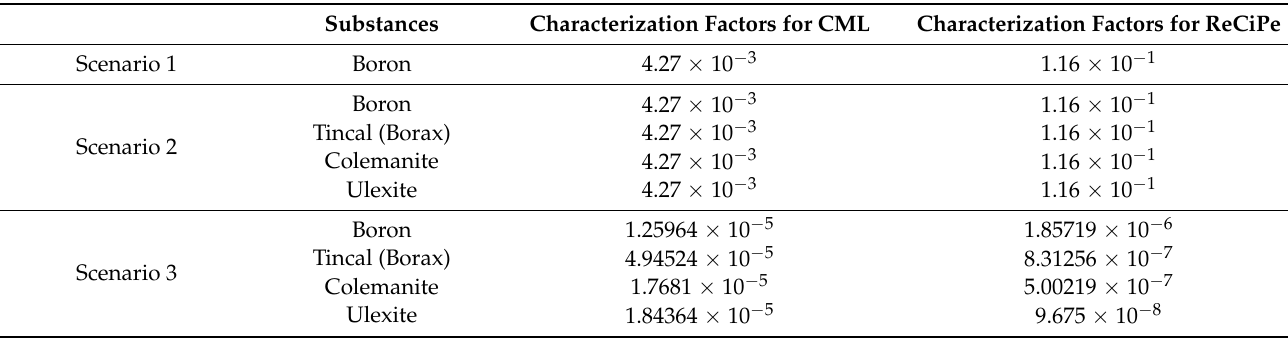
Figure 6. Results with ReCiPe expressed in kg Cu equivalents. Table 9. Scenarios and characterization factors for each